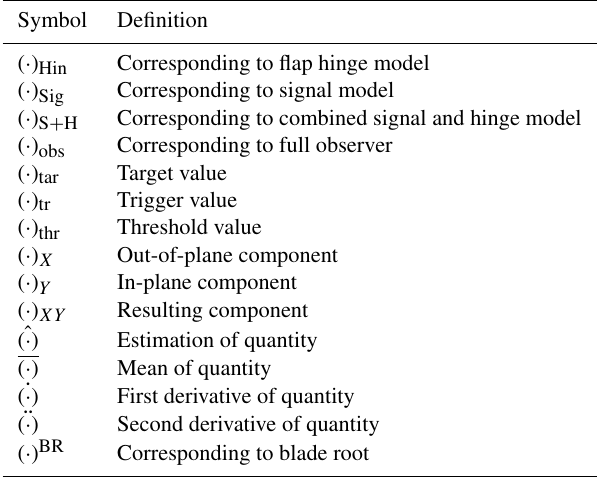
Table B3. List of sub- and